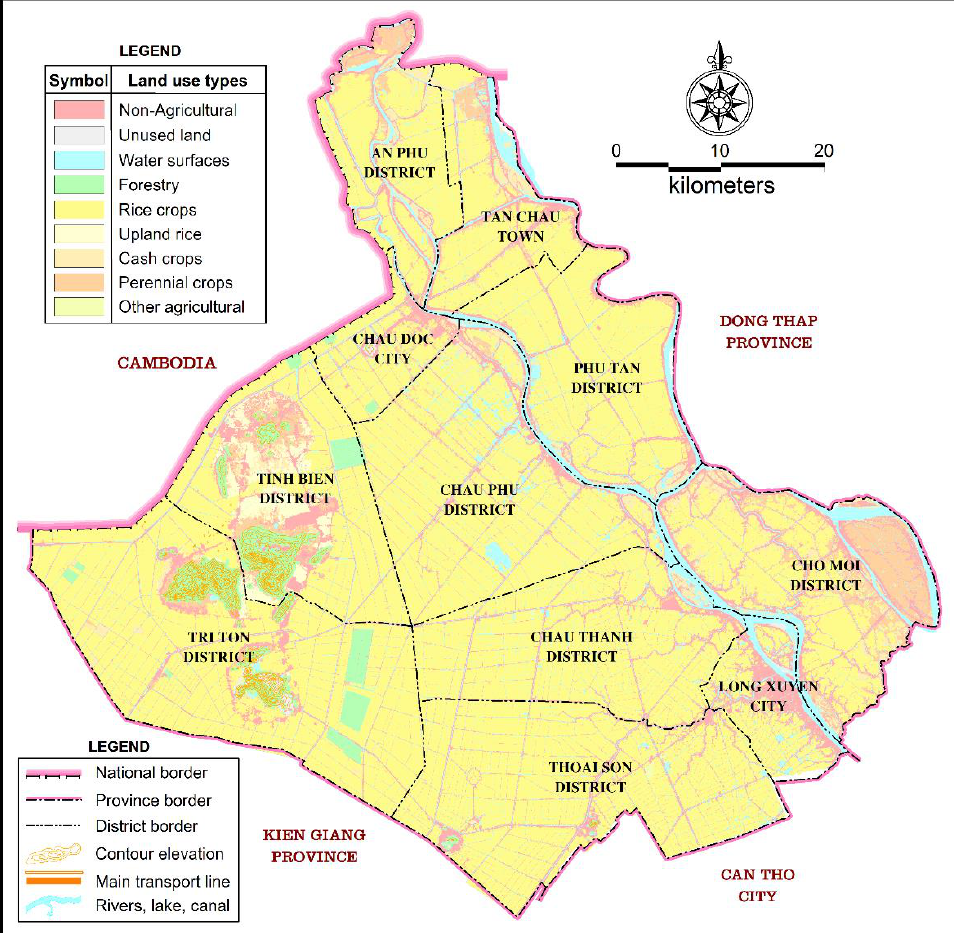
Figure 8. Land use map for An Giang province in the year 2020.